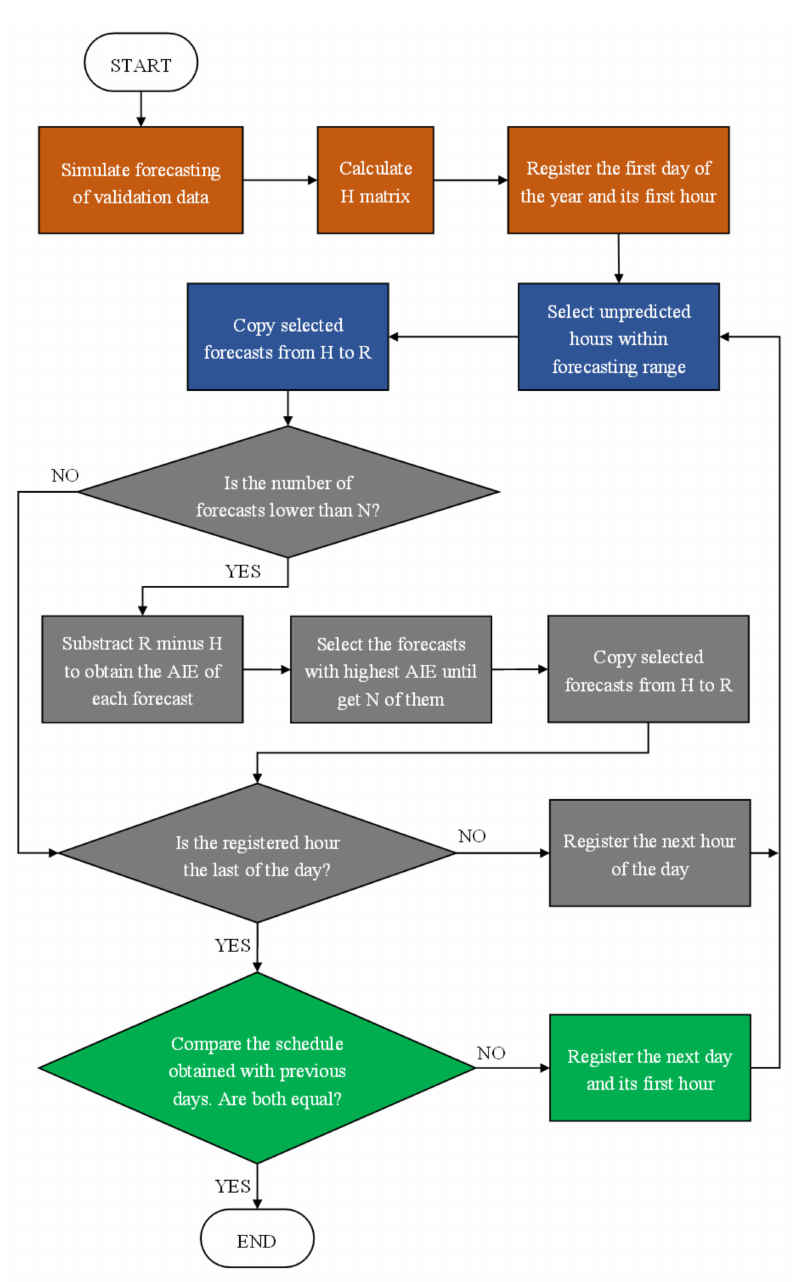
Figure 3. Algorithm flow